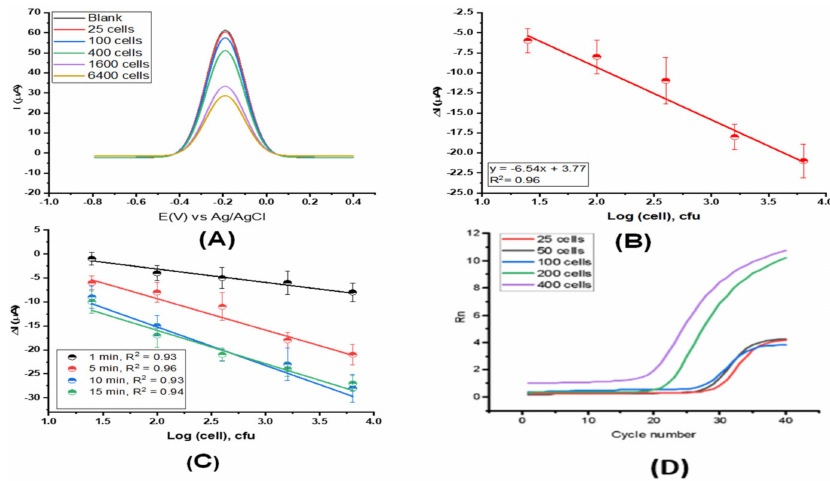
Figure 4. Sensing study of E. coli bacteria on the sensor. ( A ) Baseline-corrected SWVs of the 5.0 mM [Fe(CN)6] 3 − /4 − redox probe containing 0.1 mol · L − 1 KCl as the supporting electrolyte after